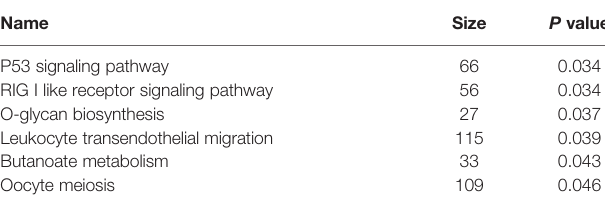
TABLE 4 | Becn1 -enriched signal pathway in gastric cancer according to the KEGG